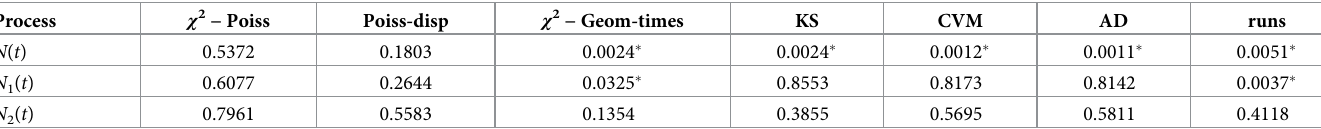
Table 4. p-values of different test for N ( t ), N 1 ( t ) and N 2 ( t ) processes. Significant differences ( α = 0.05) are identified with an asterisk ( � ).